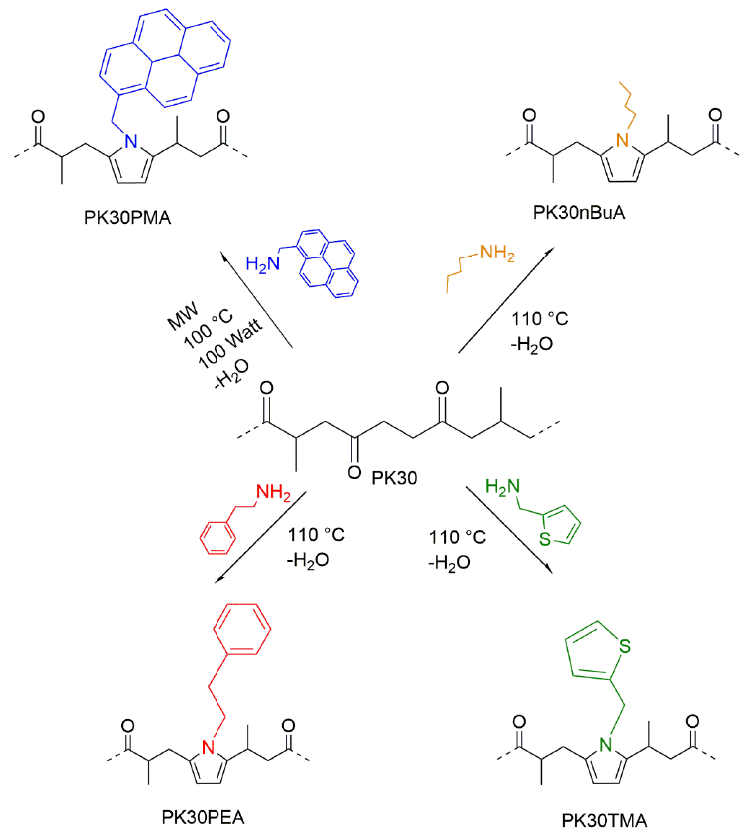
Scheme 1. Schematic representation of modified polyketones (PKs) with different